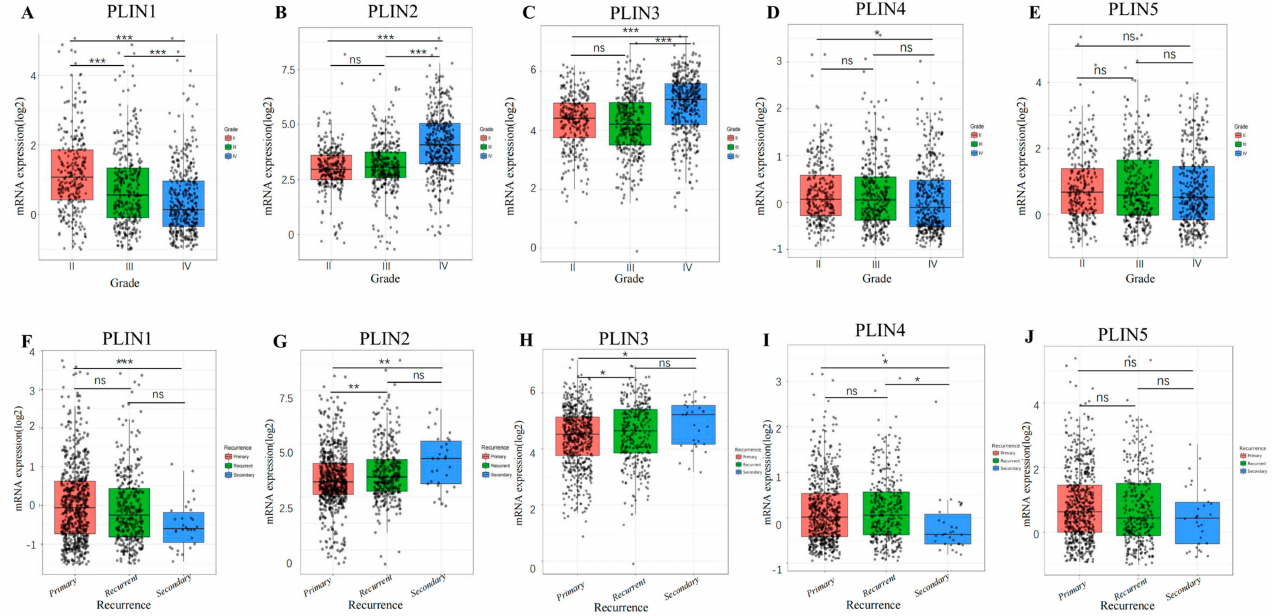
Figure 3. Correlation analysis of PLINs and clinical features of glioma. ( A − E ) The mRNA expression levels of PLIN1-5 in different glioma World Health Organization classifications (* p < 0.05; ** p < 0.01; *** p < 0.001, ns: no significance) ( F − J ) Comparison of mRNA expression levels of PLIN1 − 5 in primary, secondary, and recurrent